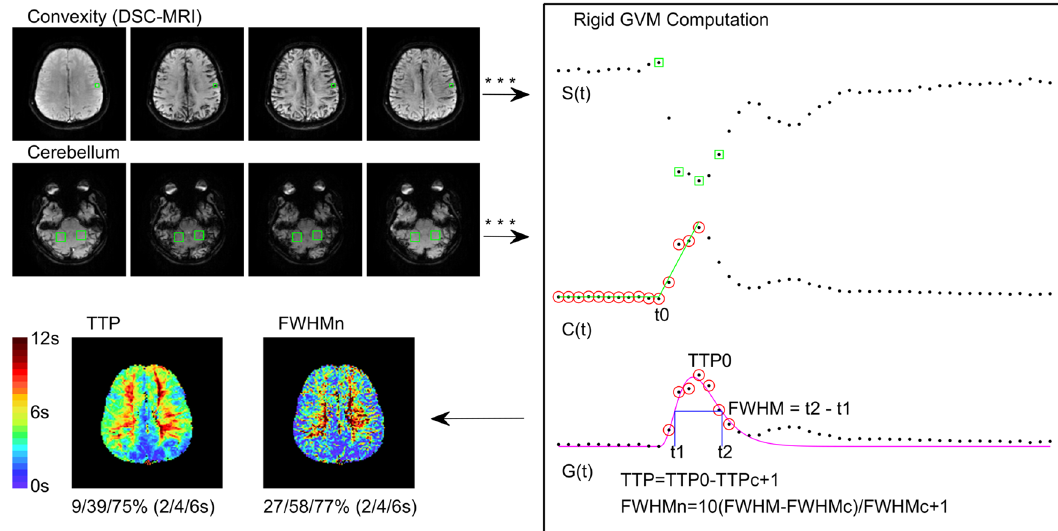
Figure 1. Derivation of TTP and FWHM perfusion maps (patient 1, the earliest scan). Brain tissues in the convexity slice (S(t) is sampled at the small box) and manually selected cerebellum references (green boxes) are computed by the proposed rigid GVM approach. In rigid GVM computation, green squares indicate the sampling time of four MRI images on the left and red circles indicate data points used in model fitting. TTP 0 and FWHM are normalized using the listed empirical formulas and color-coded from 0 to 12 s. Normalized areas (in percentage) at thresholds of 2, 4, and 6 s are given under each